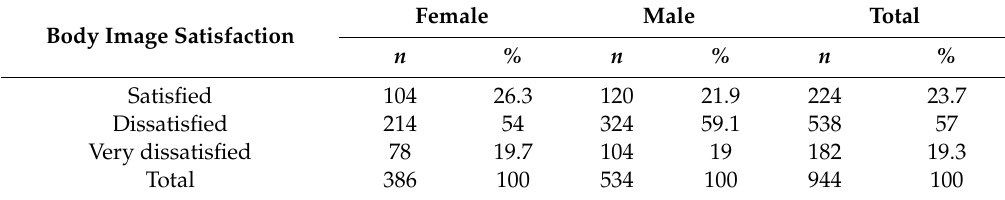
Table 2. Distribution of Participants according to Body Image Satisfaction and